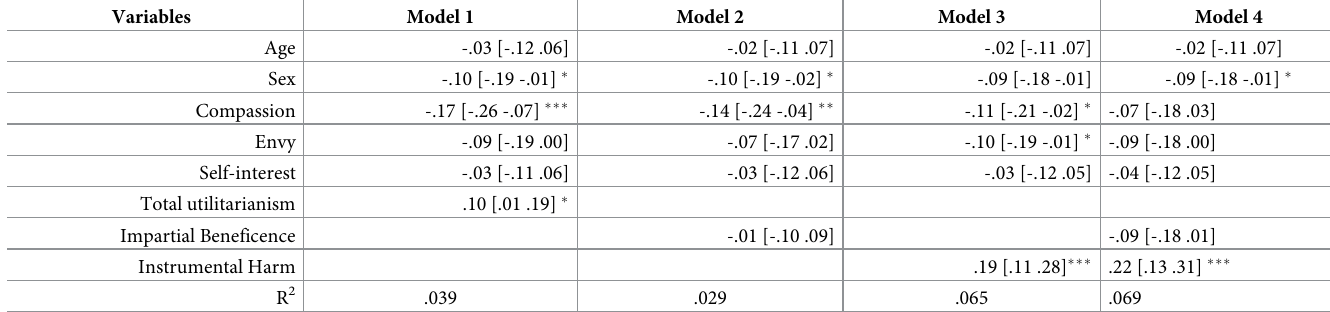
Table 6. Regression models predicting scores of the mutualism